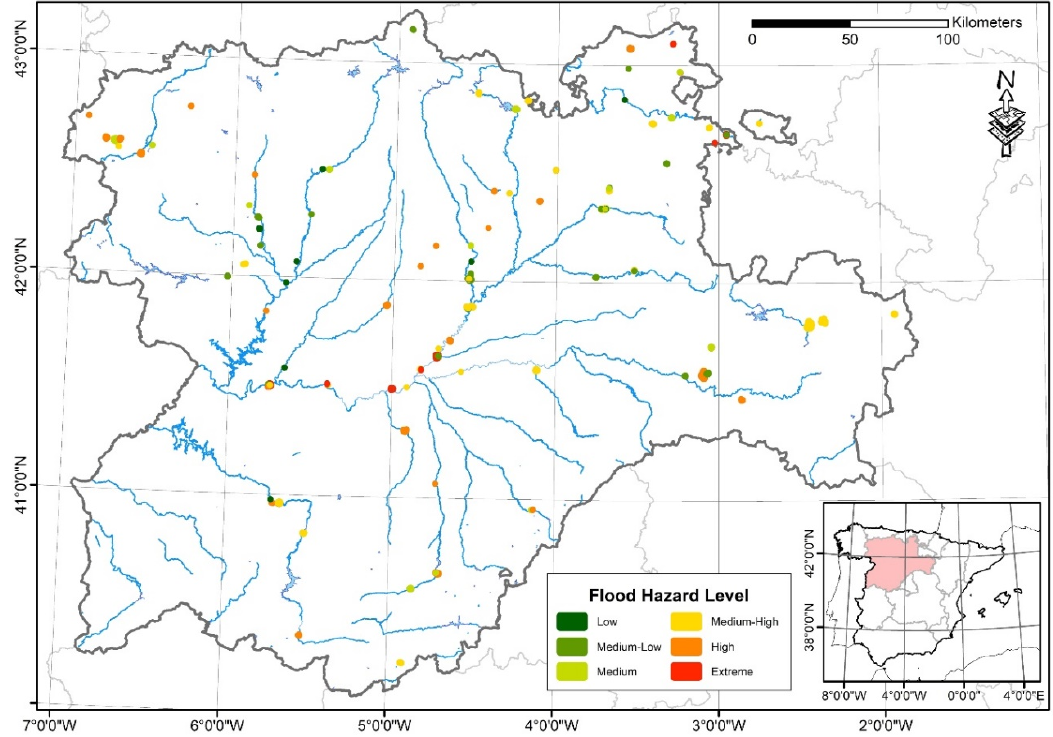
Figure 5. Spatial distribution of BICs in Castile and León region and their associated flood hazard level.